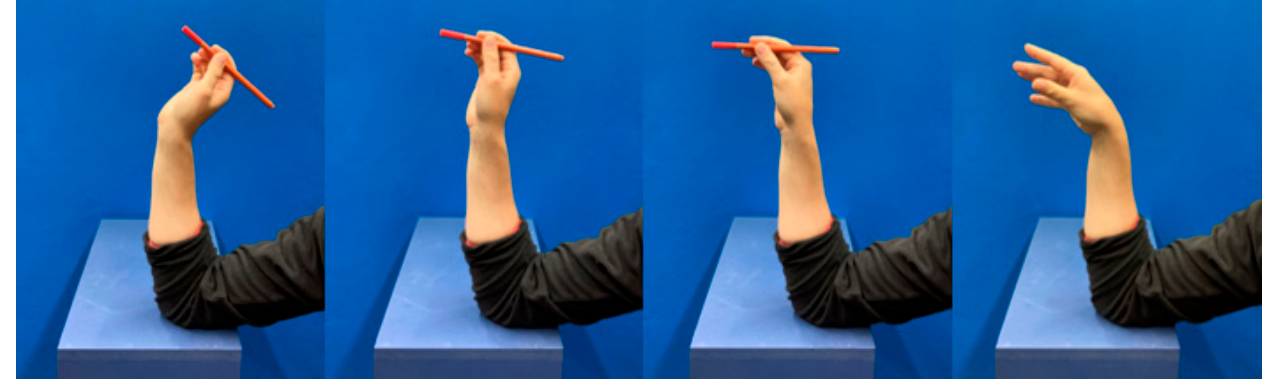
Figure 2. Sequence of the dart-throwing motion task.